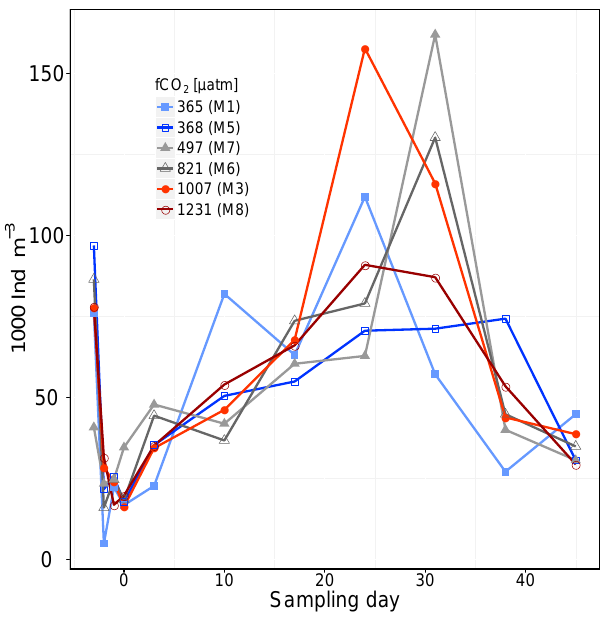
Figure 5. Mesozooplankton total abundance. According to temper- ature variations and the first CO 2 manipulation, different experi- mental phases were defined: phase 0 = t − 5 to t 0 , phase I = t 1 to t 16 , phase II = t 17 to t 30 , phase III = t 31 to t 43